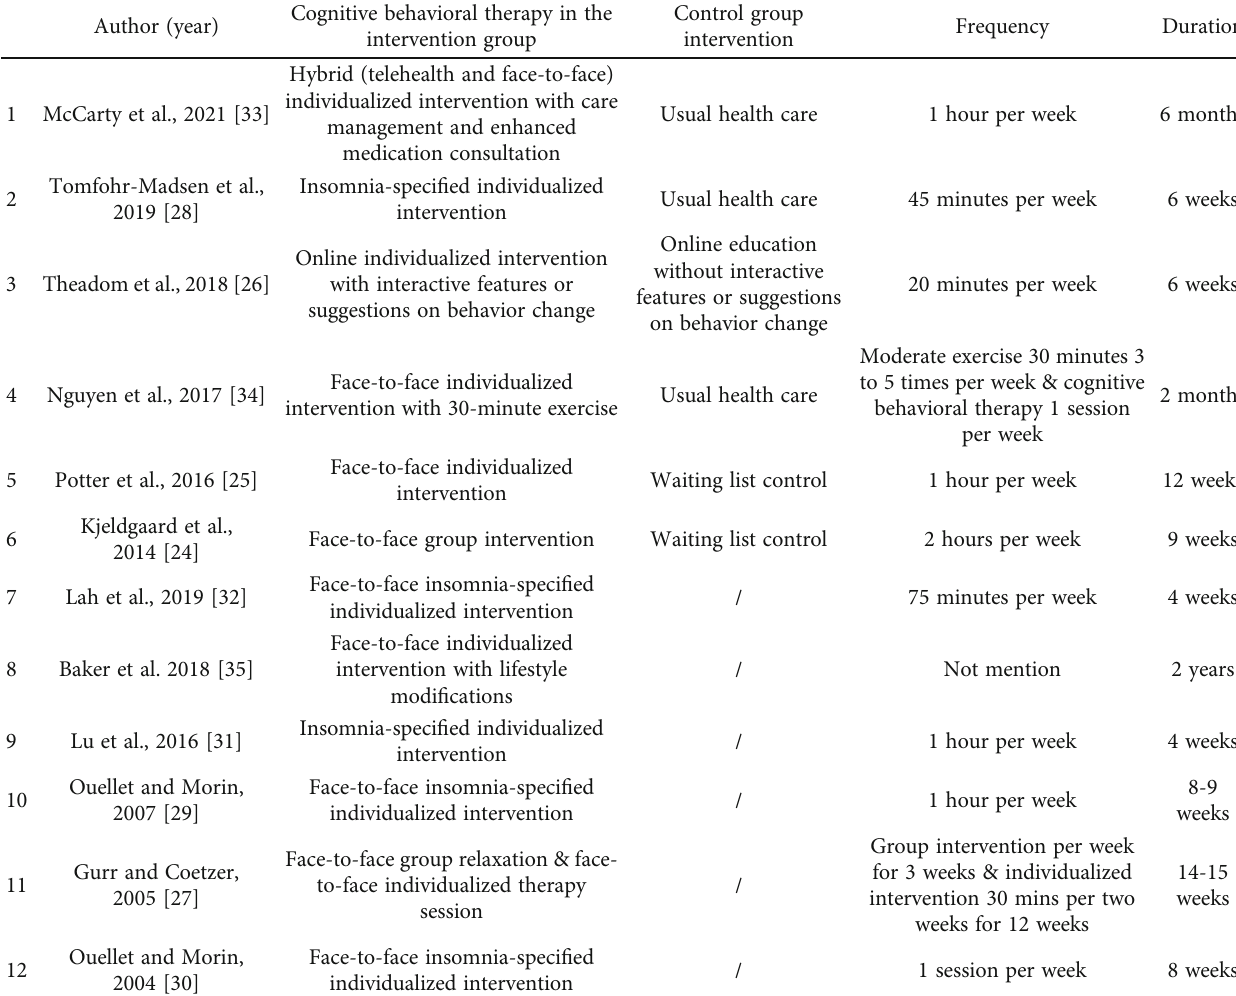
Table 2: Cognitive behavioral therapy and control interventions in the included parallel-group trials. Author